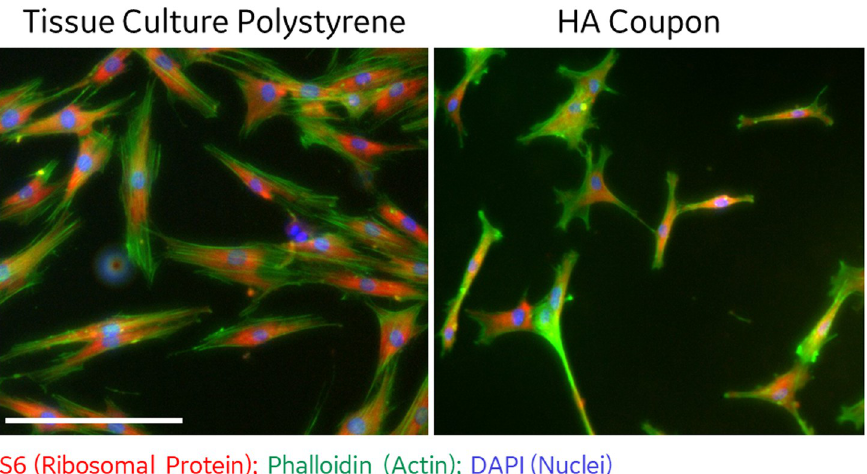
Fig 3. MSCs morphology on DLP printed coupons. MSCs seeded onto tissue culture polystyrene (12-well plate) and DLP printed HA coupon were fixed and stained for S6 ribosomal protein (red, conjugated primary antibody), actin (green, phalloidin dye), and nuclei (blue, DAPI) after 24 hours of culture. Image taken at 20x objective magnification using IN CELL analyzer, demonstrates a typical spindle morphology on coupons. Scale bar 50 μ m.